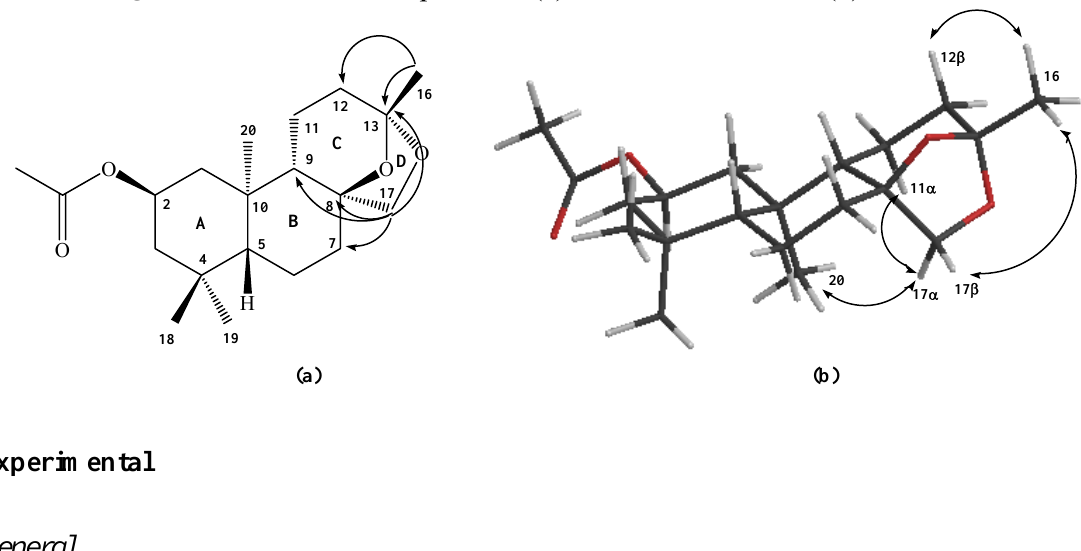
Figure 2 Structure of compound 6 . (a) HMBC correlations. (b) NOE